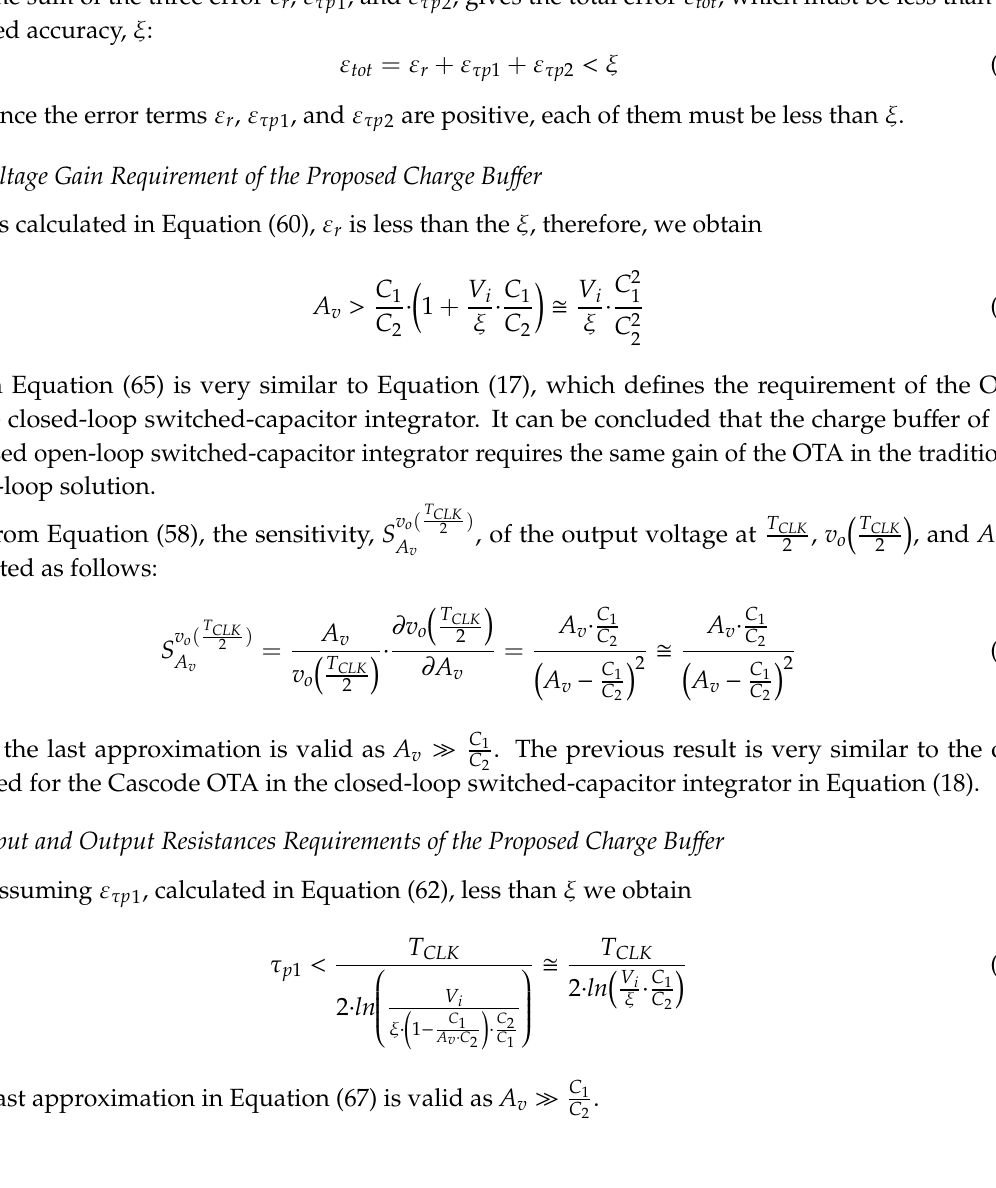
Figure 8. Output voltage behavior of the open-loop switched-capacitor integrator in the linear regime.